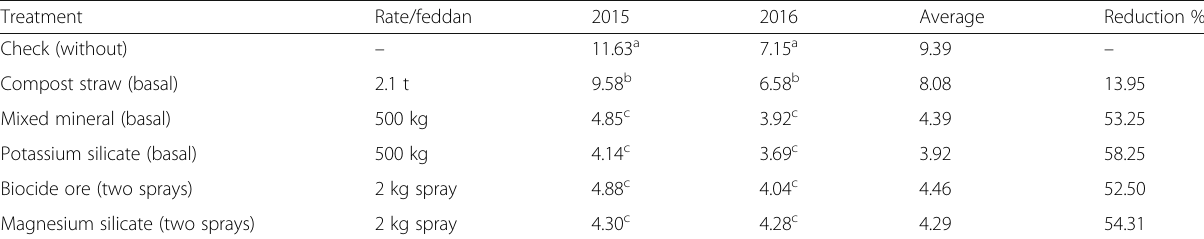
Table 3 Influence of silica materials application on the rice stem borer, Chilo agamemnon , infestation, assessed as percentages of rice plant white heads